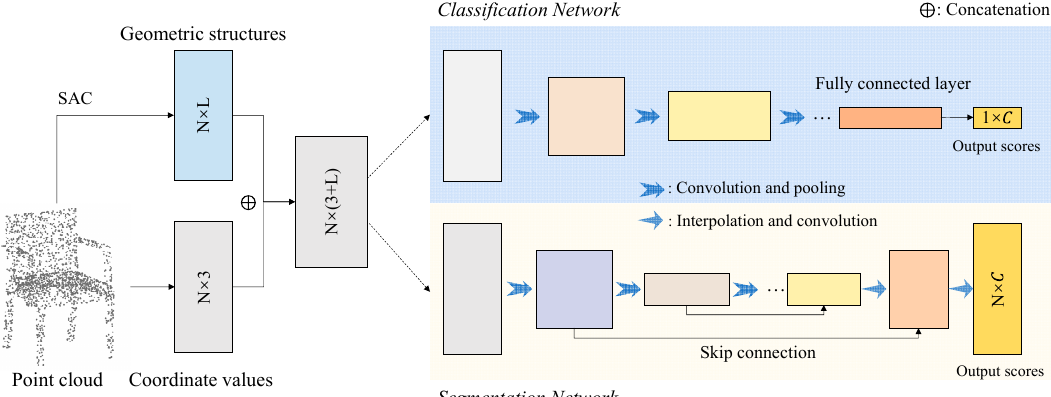
Figure 4. Architecture of the proposed point cloud deep learning networks. The output of our SAC is an L -dimensional geometric feature vector for each point, which can be easily combined with other point cloud deep learning networks. In this work, both classification and segmentation networks are constructed with our SAC. The output of the classification network is a category label for the entire point cloud, while the segmentation network aims to assign each point a reasonable category label. The classification and segmentation networks can be implemented using other existing point cloud deep learning networks (e.g., PointNet, PointNet ++ , and KCNet), and their detailed architectures and parameters are then subsequently determined.